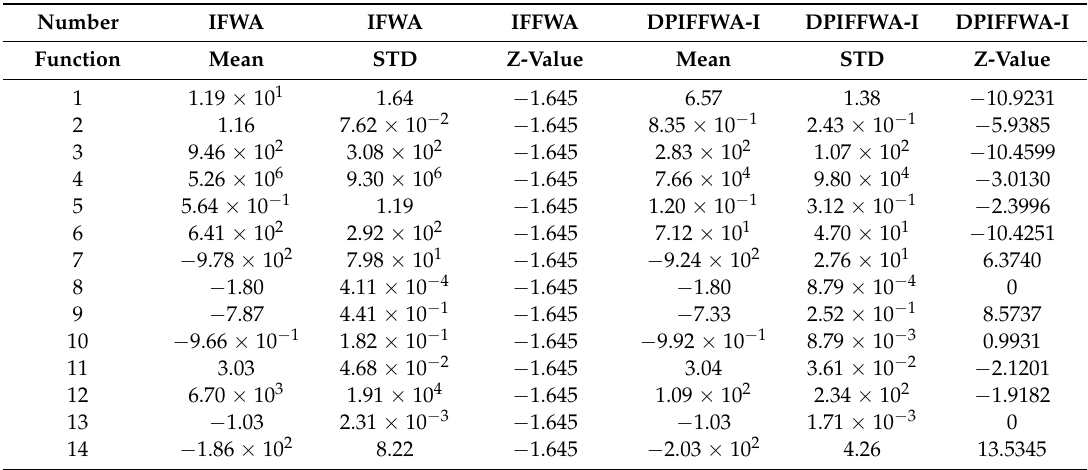
Table 16. Hypothesis test between IFWA and DPIFFWA-II with SI =